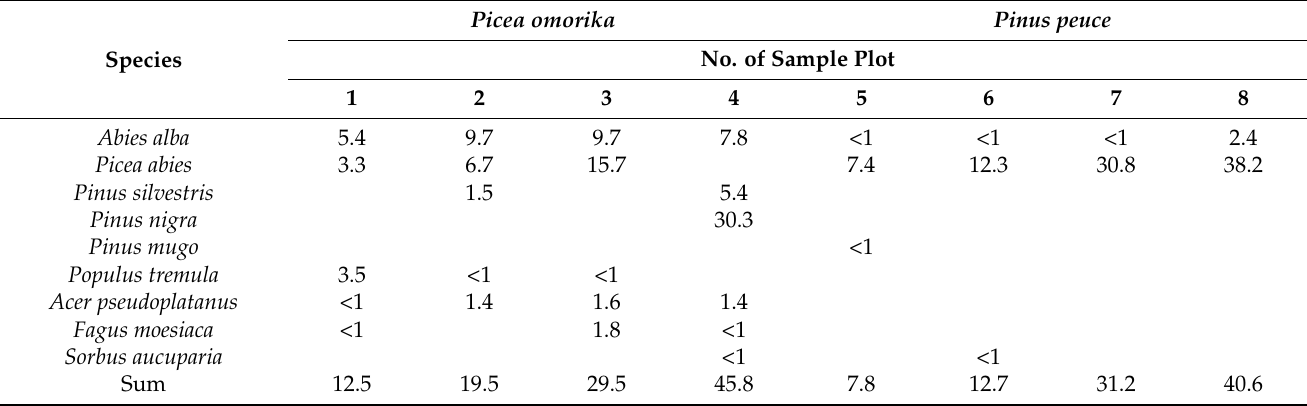
Table 1. The shares of admixed tree species in the investigated stands expressed in percentage of volume per admixed species. Picea omorika Pinus Species